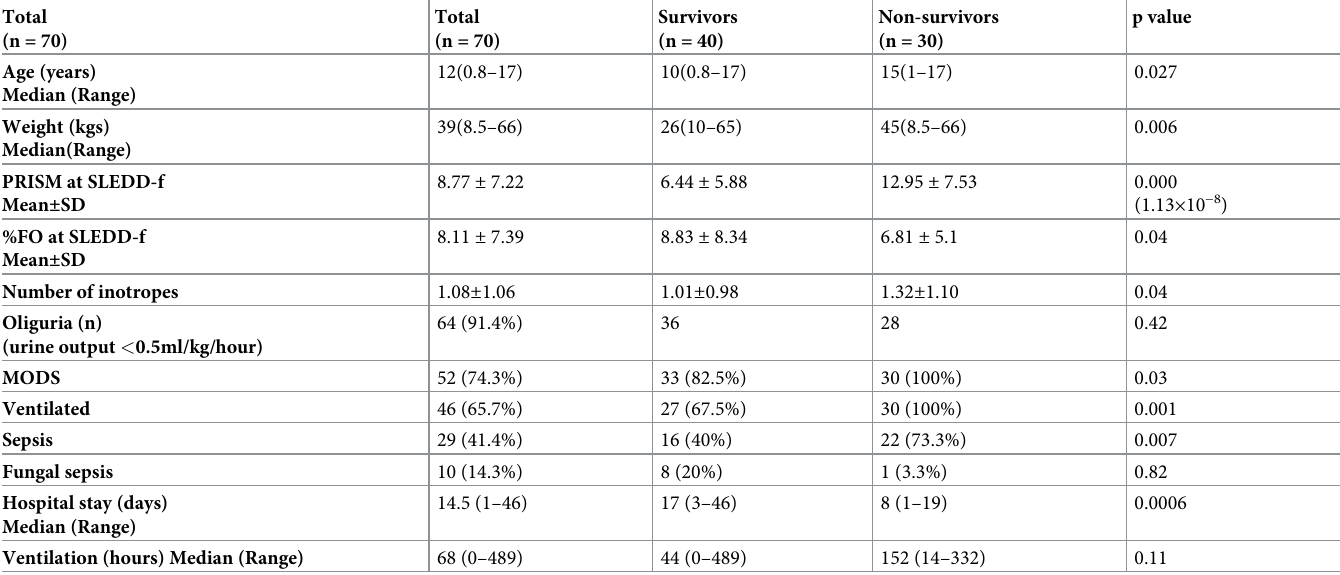
Table 1. Baseline